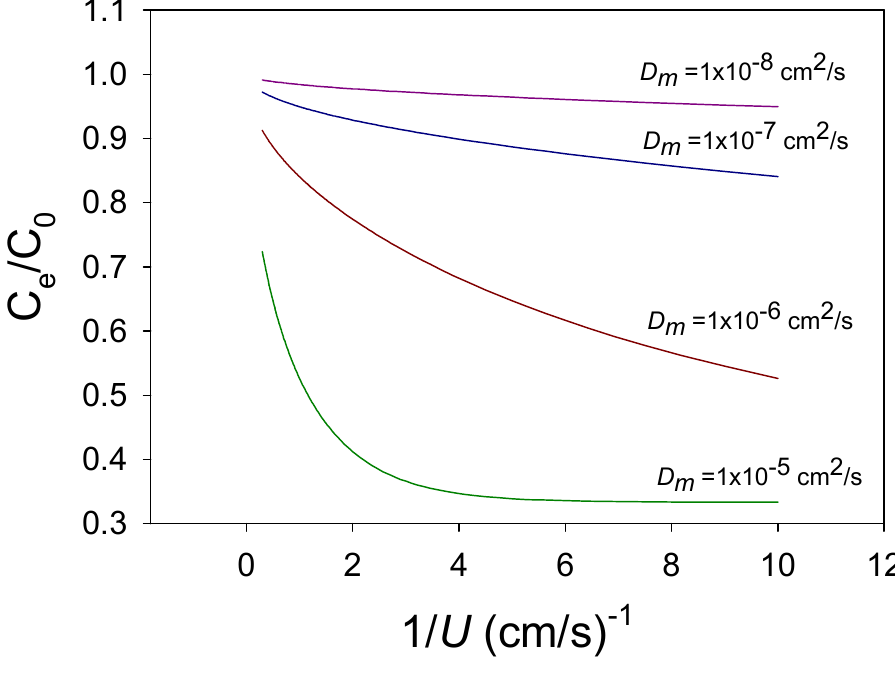
Fig. 3. Continuous infusion method. Outlet to inlet concentration ratio versus inverse average velocity (1/U) for different values of diffusivity, D m . Channel dimensions are as given in the main